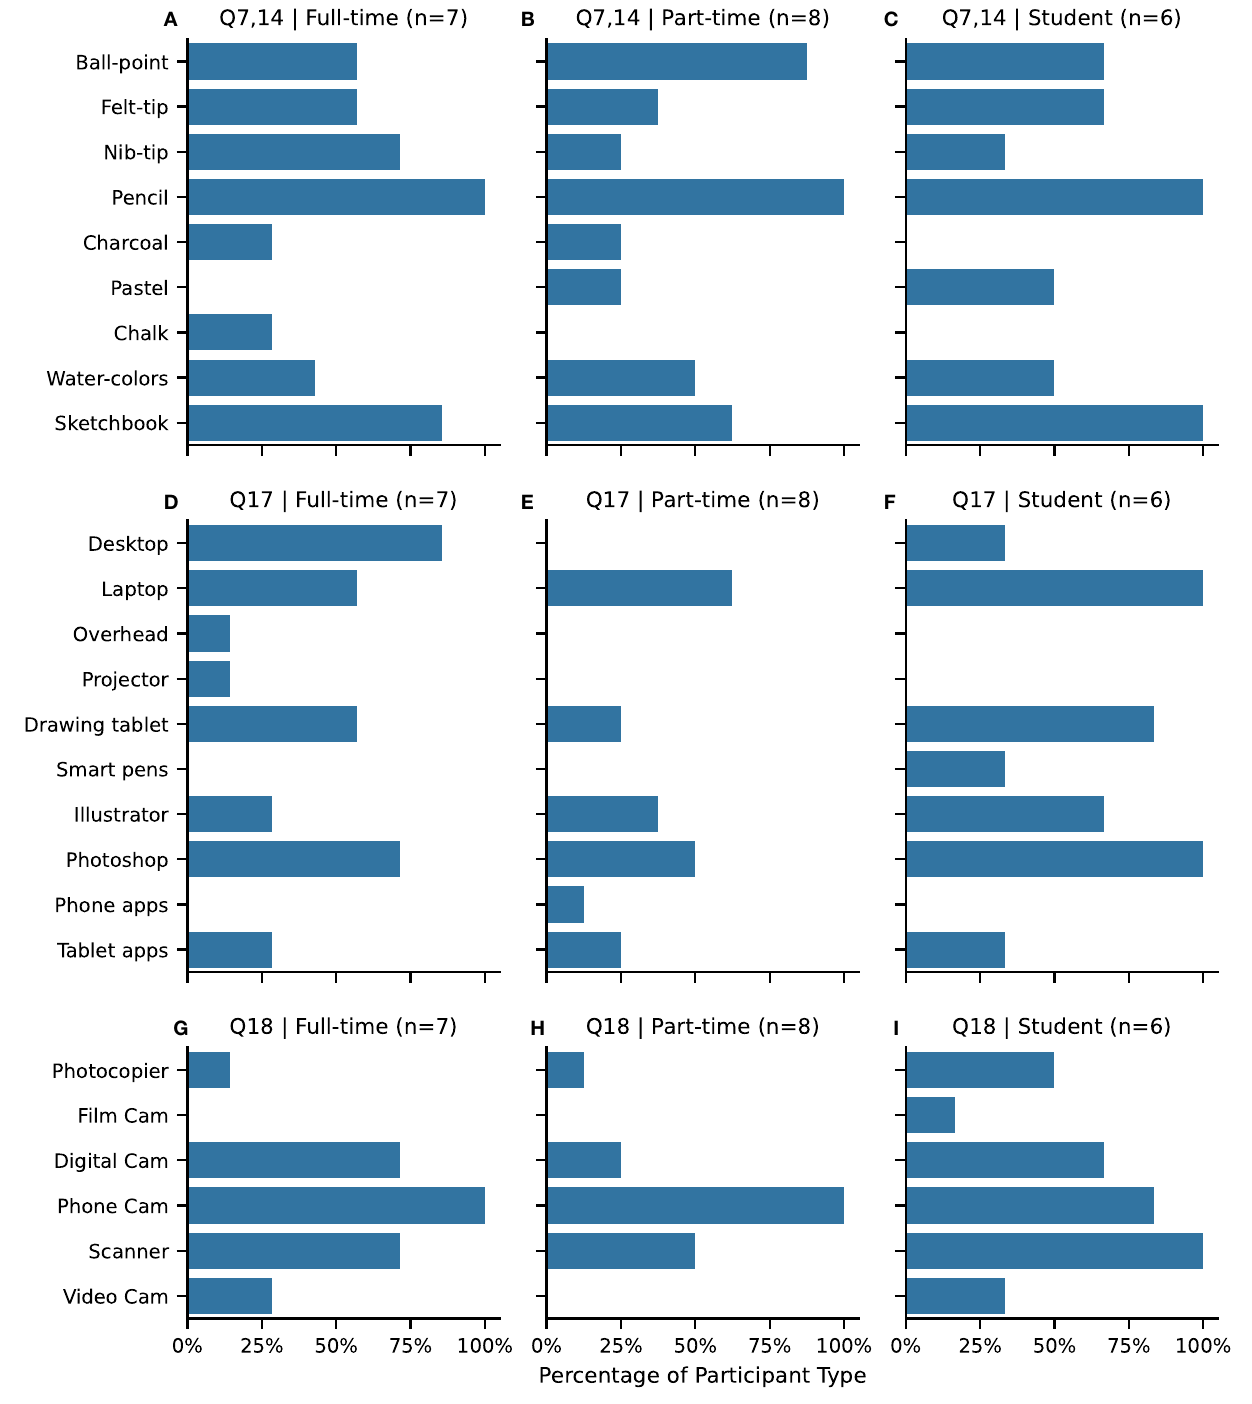
Frontiers in Robotics and AI |